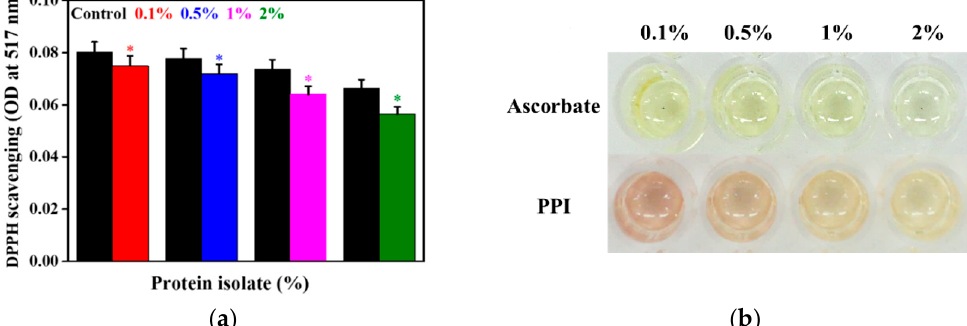
Figure 4. Measurement of the antioxidant property. ( a ) DPPH scavenging activity of PPI, with reference to an equivalent concentration of ascorbate. ( b ) Digital photographs of the plates incubated with different concentrations of PPI. Data are the mean OD ± SD of triplicated experiments; statistical significance at * p < 0.001.